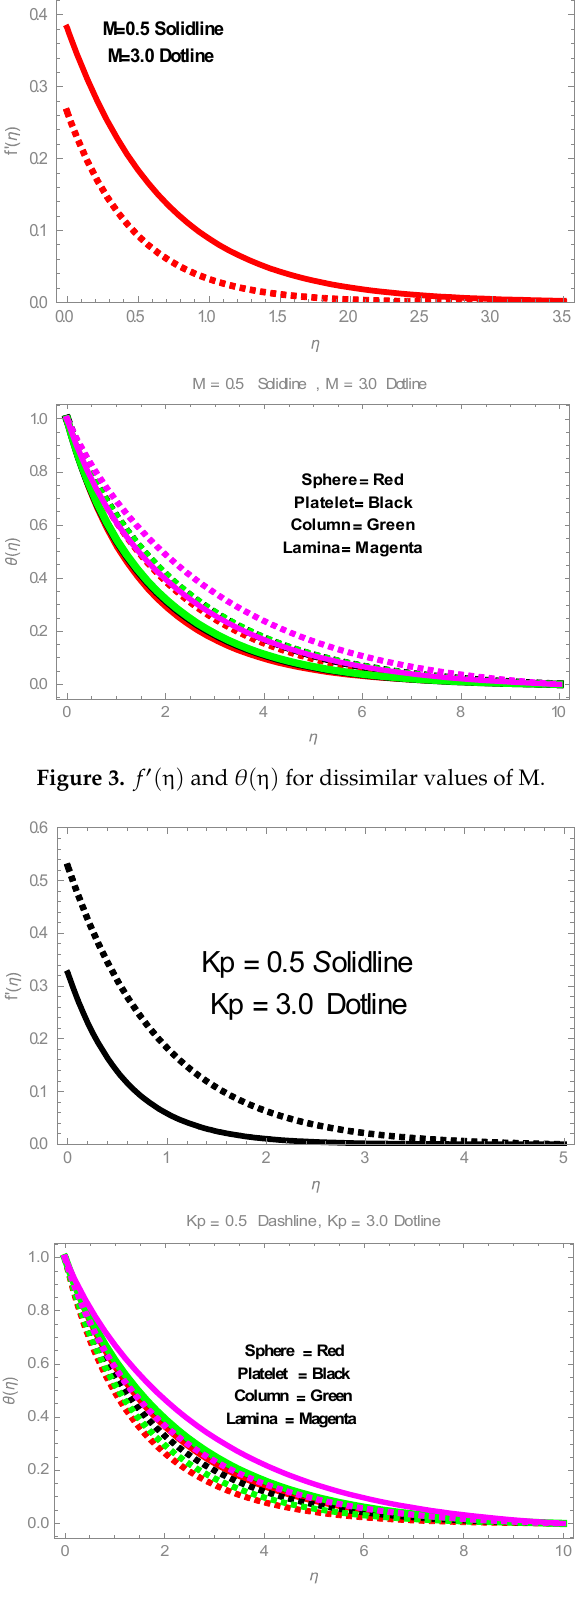
(cid:48) ( η ) and θ ( η ) for dissimilar values of Figure 4. (cid:1858) (cid:4593) (η) and (cid:2016)(η) for dissimilar values of Kp . Figure 4. f